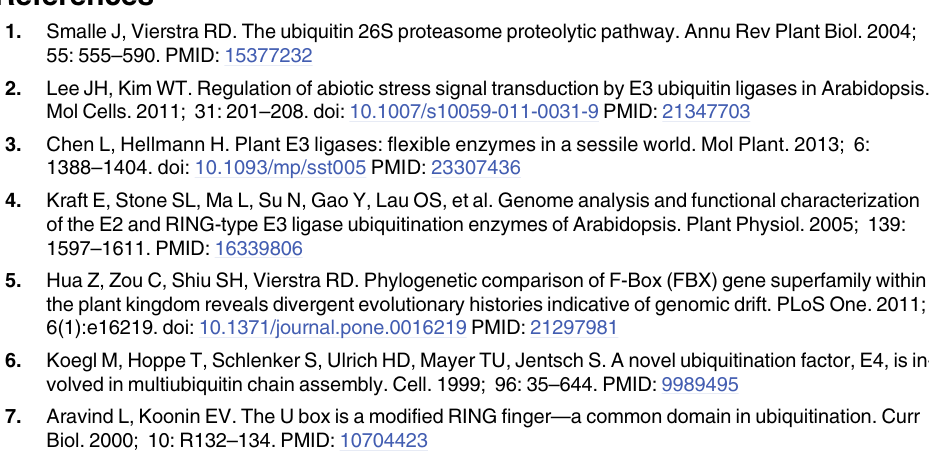
S1 Table. The primers of CrPUB genes used for real-time quantitative RT-PCR. (PDF) S2 Table. Primers sequences of the 5 selected CrPUB genes for RNAi expression analysis. A: The primers used for the amplification of RNAi expression fragments from non-conserved domain-encoding regions. B: Primers randomized in design for the amplification of RNAi ex- pression fragments. The sequence, length, Tm, GC% and product sizes of the primers are shown in the